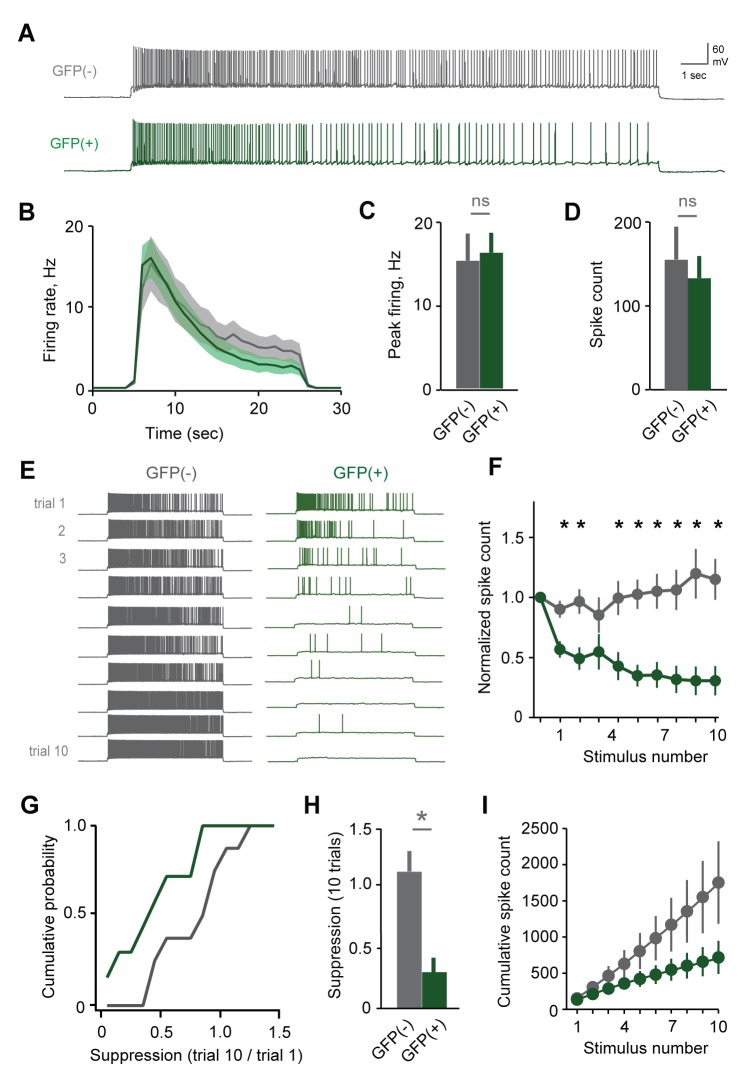
Plasticity in MC responsiveness is specific to mating-activated neurons.(A) Both GFP(-) and GFP(+) MCs show similar initial responses to current stimuli. (B) Mean firing rate profiles for GFP(+) and GFP(-) MCs in Fos-GFP females after mating (mean ± SEM; n = 7 and 11 cells in 5 and 7 mice). (C, D) Initial MC output is similar between GFP(-) and GFP(+) groups (firing rate, p=0.81; spike count, p=0.63; t-test). (E) Representative MC responses to repetitive stimulation in mated females. (F) After mating, GFP(-) MCs maintain consistent firing, but the output of stud-activated GFP(+) neurons is dramatically attenuated over time (mean ± SEM; n = 7 and 11 cells in 7 mice). (G) Cumulative histograms indicate a shift towards greater suppression in the MCs activated during mating (p=0.18; Kolmogorov-Smirnov test). (H) Mean suppression after 10 trials for GFP(-) and GFP(+) neurons (spike count on 10th vs. 1st trial: unlabeled, 115 ± 17%, p=0.41; labeled, 30.7 ± 12.3%; p=0.0017; t-test). (I) Cumulative action potential output of GFP(-) and GFP(+) MCs, averaged across all recorded neurons.DOI:
http://dx.doi.org/10.7554/eLife.25421.01810.7554/eLife.25421.019Figure 6—source data 1.This spreadsheet contains the firing rate and spike count data for mitral cells used to generate the bar plots and average data shown in Figures 6C, D, F and H.These data can be opened with Microsoft Excel or with open-source alternatives such as OpenOffice.